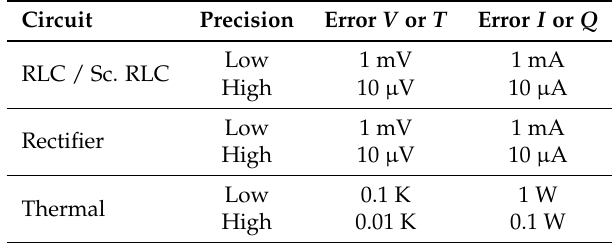
Table 5. Acceptable errors in the monitored